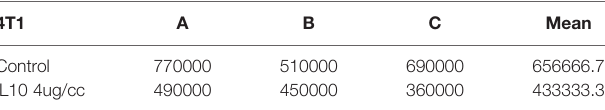
TABLE 2 | 4T1 cell counts after IL-10 treatment for three days(three replicates: A,B,C, P value=0.01,sample means are